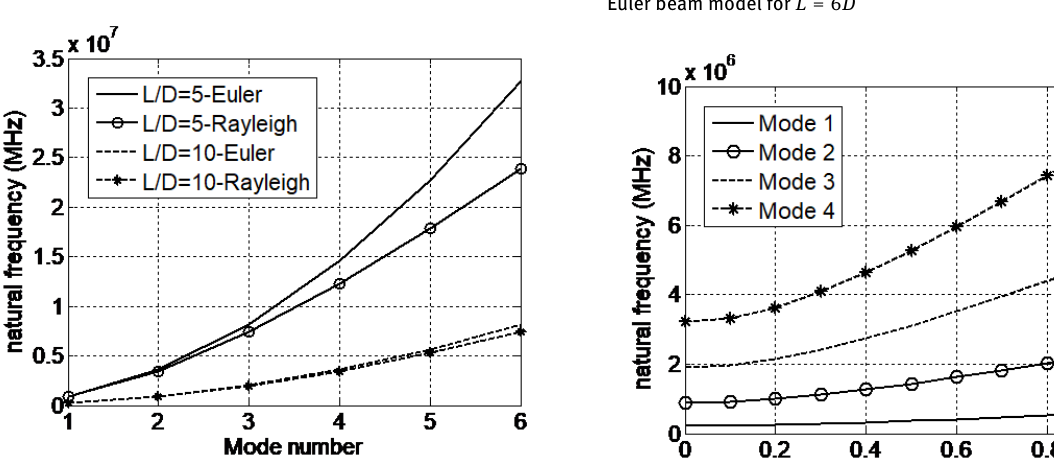
Figure 7: Variation of the first four natural frequencies with respect to length scale parameter-to-diameter ratio based on Rayleigh beam model for L = 6